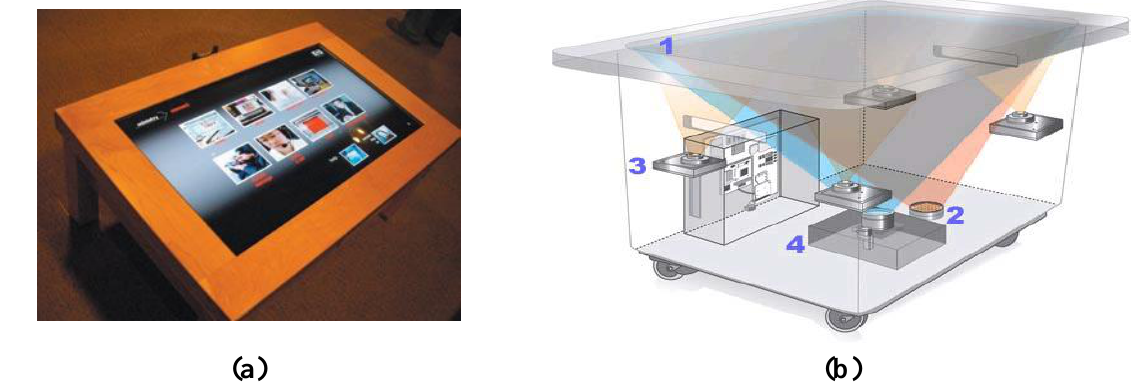
Figure 1. (a) A Microsoft Surface Computer. (b) The structure of Microsoft Surface (1 is the transparent panel, 2 is the infrared source, 3 is a infrared camera, 4 is the